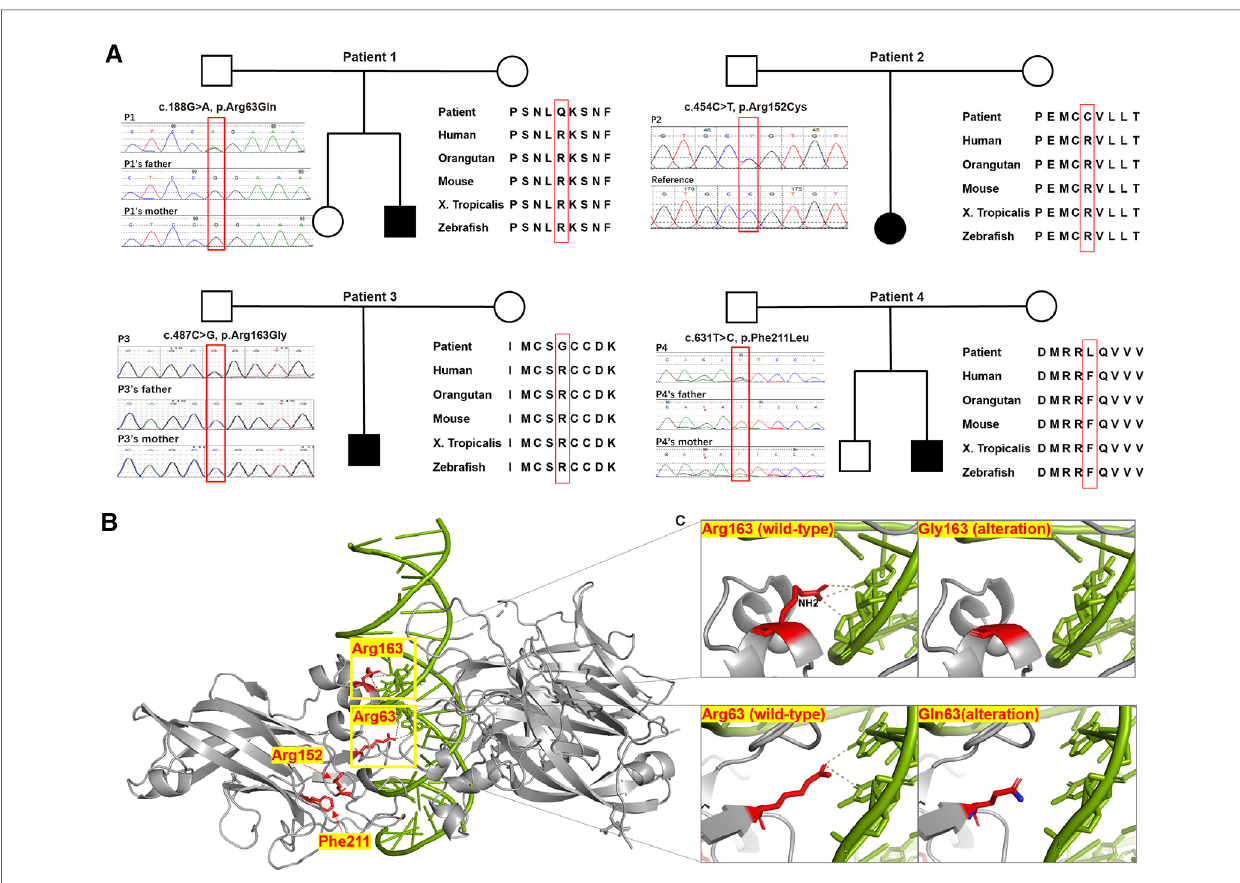
FIGURE 2 Pedigree chart, evolutionary conservation, Sanger sequencing results, protein structure model, and close-ups of novel variants detected in our patients. ( A ) Pedigree charts of the patients with novel EBF3 single nucleotide variants and the corresponding evolutionary conservation and Sanger sequencing results in our study. ( B ) Model of the DBD of an EBF3 dimer (gray ribbon; affected residues are shown as red sticks) bound to DNA (shown as a green duplex; DNA residues involved in hydrogen bonding with the affected protein residues are shown as sticks). ( C ) Close-up view of the effect of Arg163Gly and Arg63Gln alterations on hydrogen bond